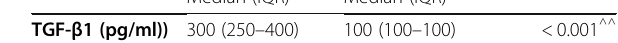
Table 3 Serum level of transforming growth factor β 1 in both groups